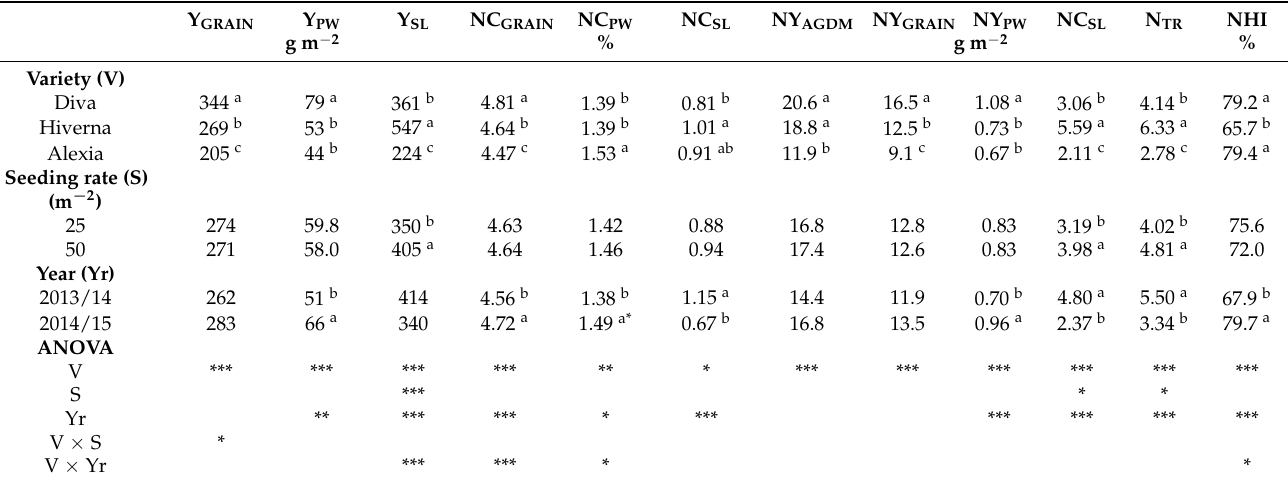
Table 1. Yields, N concentrations and N yields of faba bean as affected by variety, seeding rate and